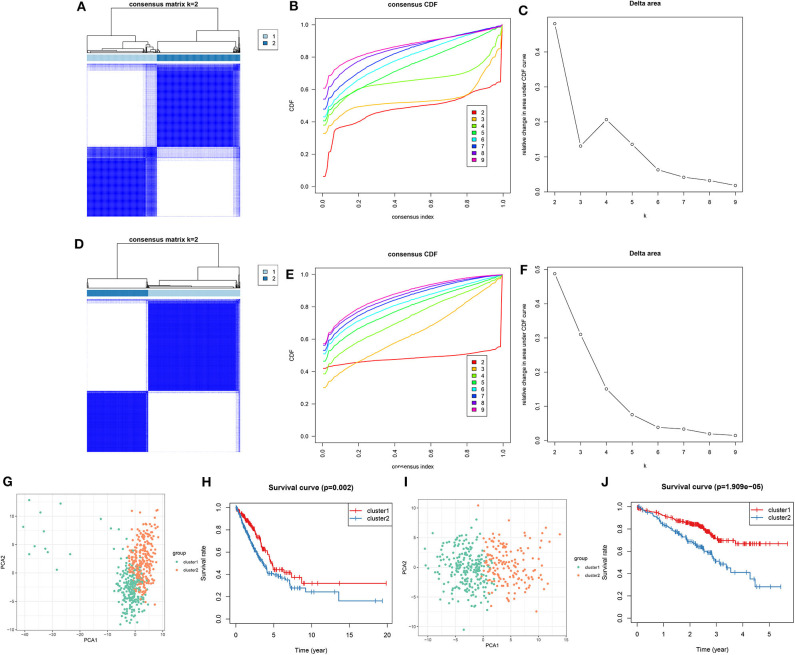
Consensus clustering of DNA repair-associated genes clustered LUAD samples into two clusters with distinct clinical outcomes. In the training set, (A) the heat map showing the consensus matrix when k = 2. (B) Consensus clustering cumulative distribution function (CDF) under k = 2–9. (C) Relative change in area under CDF curve. In the validation set, (D) the heat map depicting the correlation between cluster 1 and 2. (E) Consensus clustering CDF under k = 2–9. (F) Relative change in area under CDF curve. (G) PCA of the expression profile of DNA repair genes from cluster 1 and 2 in the training dataset. (H) Kaplan-Meier OS curve between cluster 1 and 2 in the training set. (I) PCA of the expression profile of DNA repair genes from cluster 1 and 2 in the validation dataset. (J) Kaplan-Meier OS curve between cluster 1 and 2 in the validation dataset.